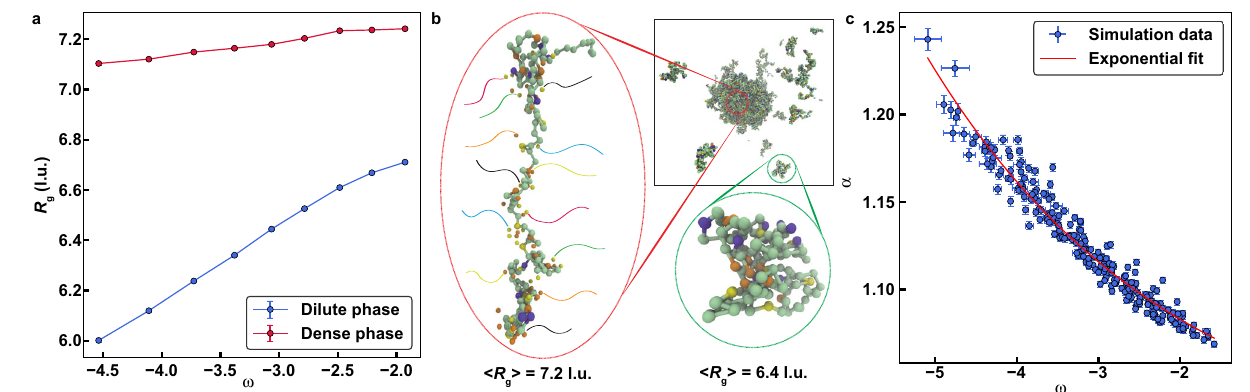
Fig. 2 | Comparison of conformations within dense vs. dilute phases. a R g of chains in the dilute (blue) and dense phase (red) derived from condensates of the wild-type A1-LCD plotted against the width of the two-phase regime (see text). b A schematicdepictinghowintramolecularsticker-stickerinteractionspromotechain compaction in the dilute phase, whereas distinct intermolecular sticker-sticker interactions promote chain expansion in the dense phase. Here, each chain is depicted as a fl exible tail of distinct color. c Swelling ratio, which quanti fi es the